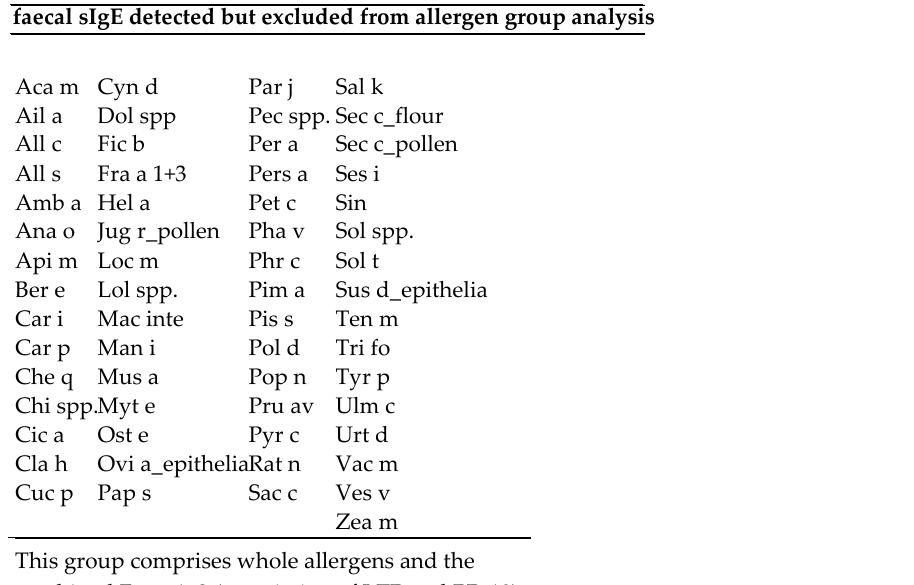
Figure 2. International Union of Immunological Societies (IUIS) classification of allergens. The allergen multiplex assay employed in this study comprised 300 allergen extracts and molecules representative of a wide array of plant and animal allergenic sources, of which 186 were bound by fecal sIgE. These 186 allergen extracts and molecules were grouped as a function of their state-of-the-art clinically relevant specificity and cross-reactivity [20]. The allergen extracts and molecules with defined specificity, e.g., fish extracts, allergens, or seed storage proteins, were assigned to corresponding groups. The cross-reactive families of allergen molecules were grouped together, e.g., profilins. The allergen extracts with extended cross-reactivity and limited informative values on genuine sensitization, e.g., grass pollen extracts, were excluded from the analysis. Table 2. Allergen families associated with increased frequency of neonatal fecal sIgE in patients diagnosed as allergic to cow’s milk or asthmatic at the age of 1 year. Excluding the meconial samples, the results were analyzed in cow’s milk-allergic patients (n = 8) compared to cow’s milk-tolerant controls (n = 9) and in asthmatic patients (n = 8) compared with non-asthmatic patients (n = 9). Asterisks indicate significant differences (* p < 0.05; ** p < 0.01; *** p < 0.001). sIgE+ p Allergens (%) 10